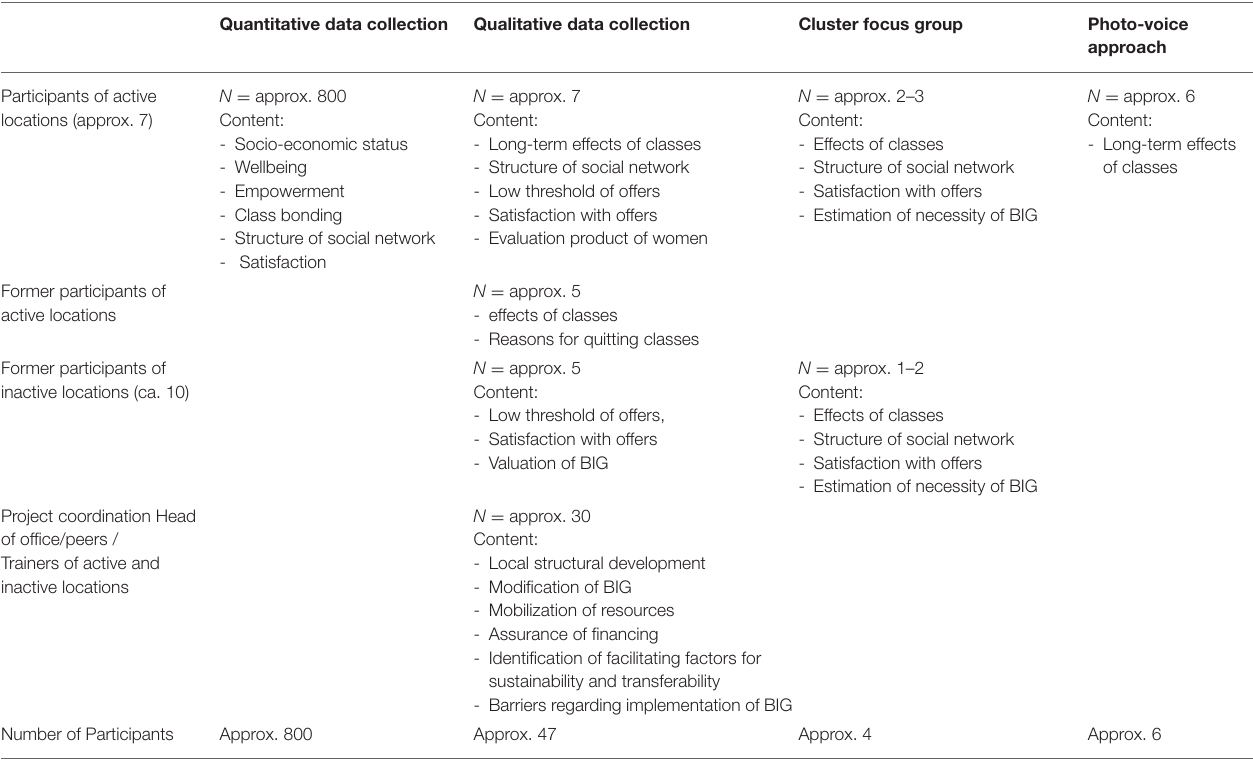
TABLE 1 | Overview of study methods, participants, and survey parameters. Quantitative data collection Qualitative data collection Cluster focus group Photo-voice